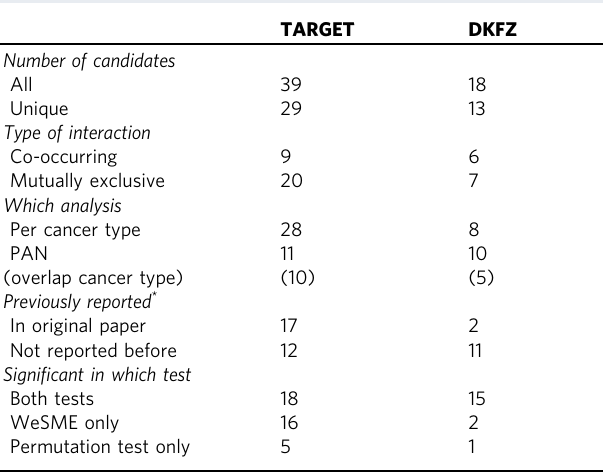
Table 1 Number of candidate genetic interactions in both data sets.